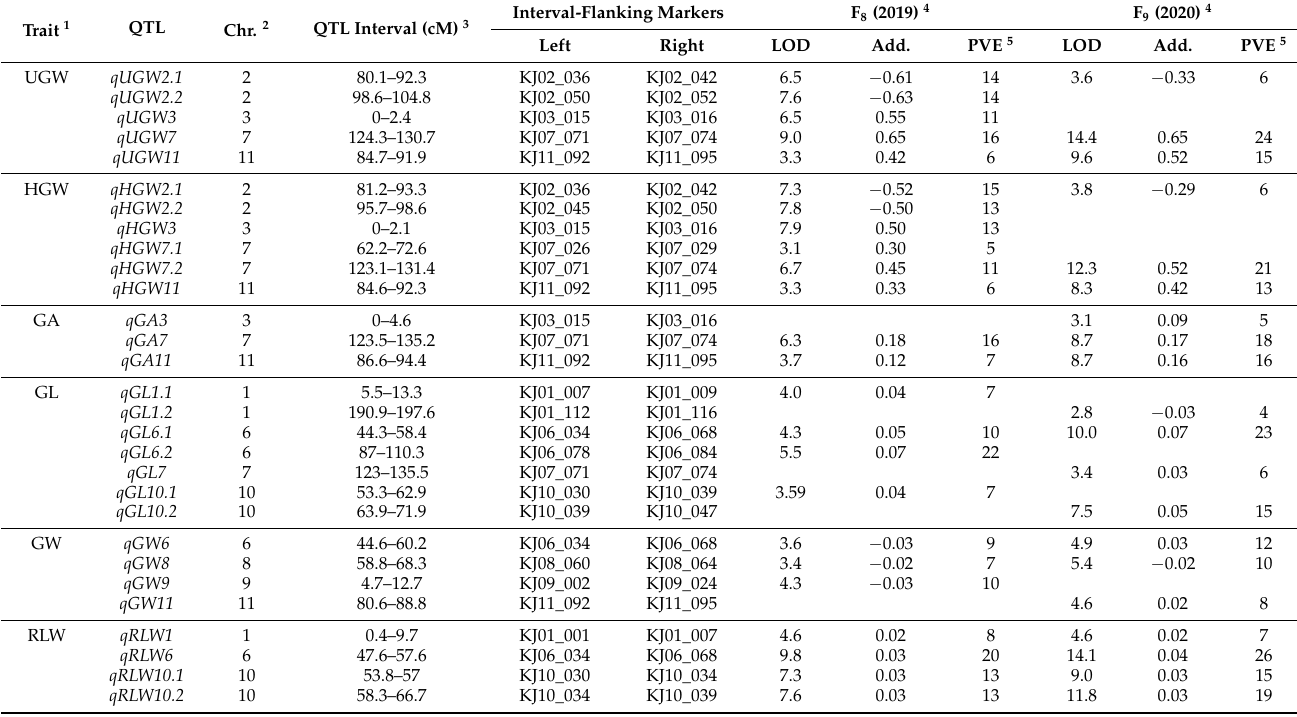
Table 2. Grain size-related QTLs detected in the RIL population derived from a cross between Odae and